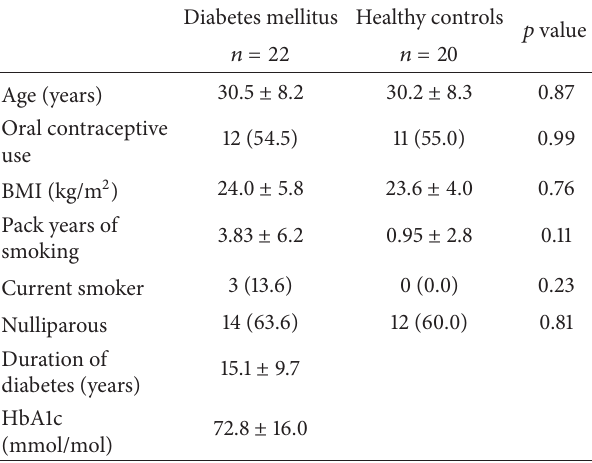
Table 1: Baseline characteristics.